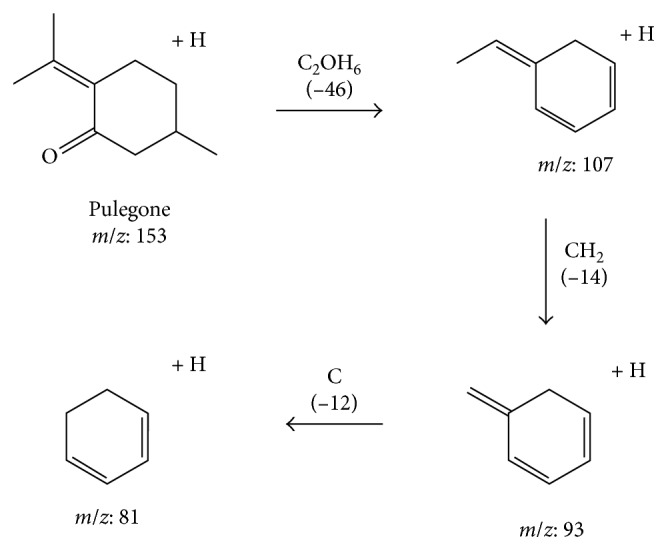
Fragmentation pathways of pulegone and its derivatives.